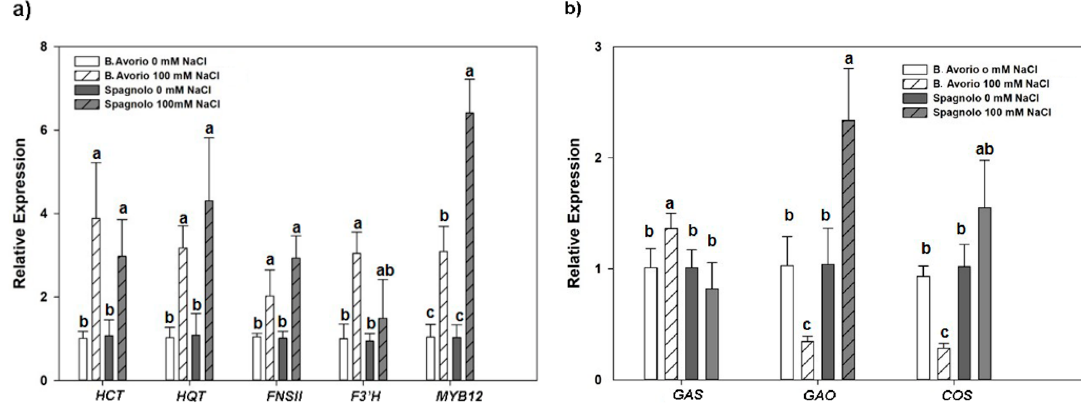
and “Spagnolo” leaves, respectively.